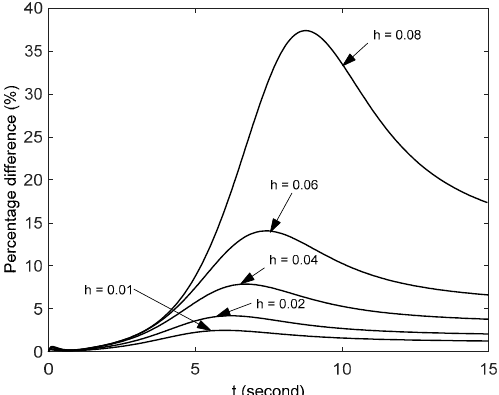
Figure 9. Percentage difference between the present method with violation correction and that without violation correction for different time steps h .